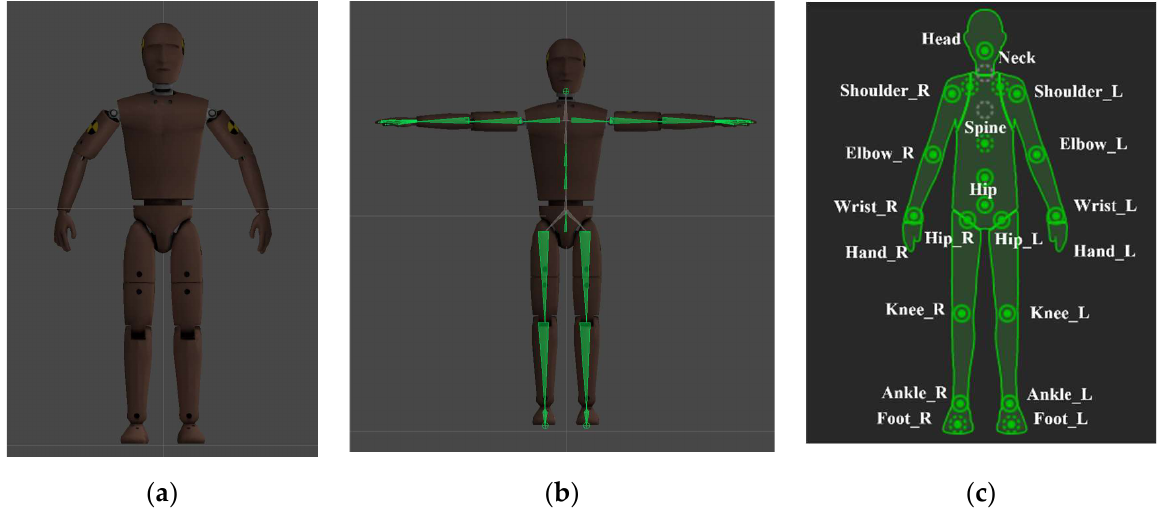
Figure 15. Avatar model information to which IK will be applied: ( a ) Avatar rigging model; ( b ) Avatar skeleton mapping; ( c ) Joint point information.